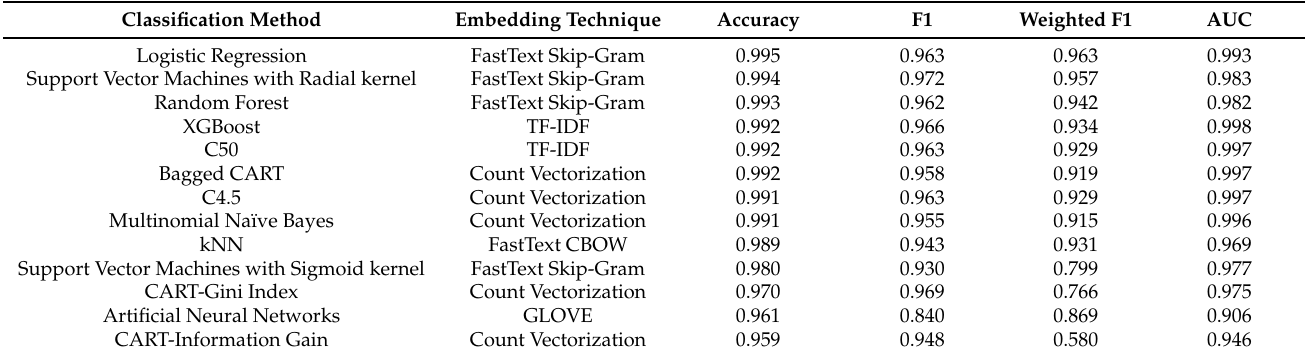
Table 8. Classification method—embedding technique with the highest